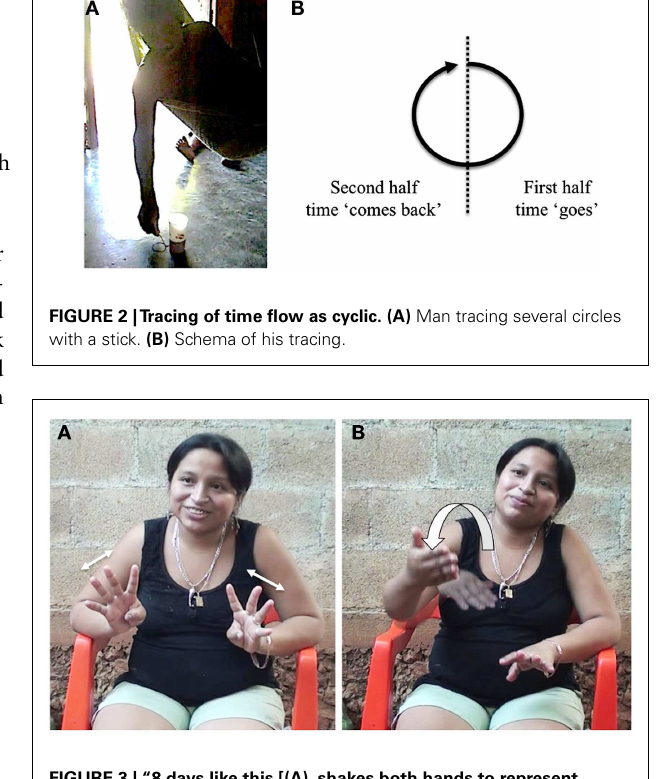
FIGURE 3 | “8 days like this [(A), shakes both hands to represent number 8] ( ... ) the days come like this [(B), makes a forward 180˚ rolling gesture to represent time passing]"